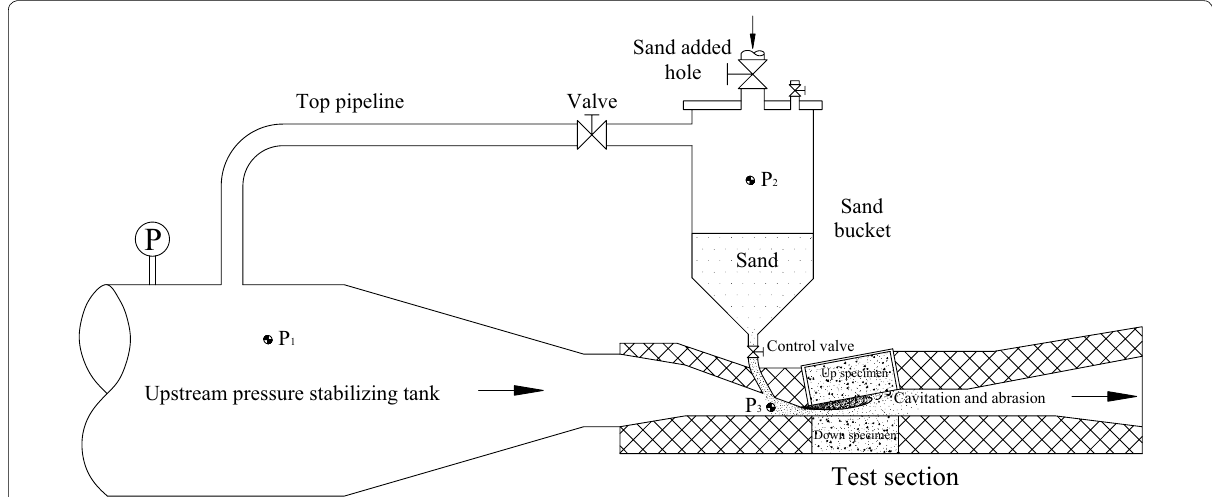
Fig. 3 Test device for the combined action of cavitation and